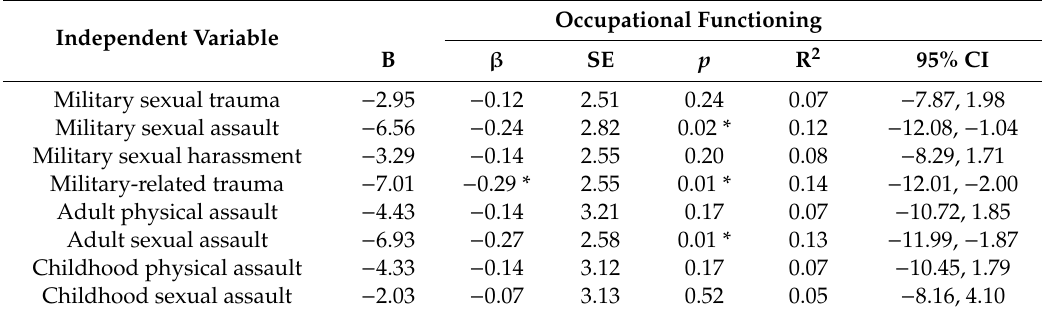
Table 1. Associations between trauma exposures and occupational functioning.